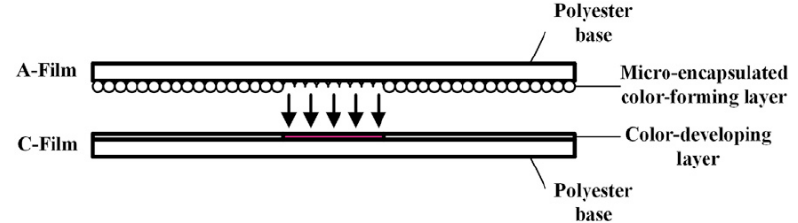
Figure 5. Measurement of pressure distribution with the pressure ‐ sensitive film [37] .